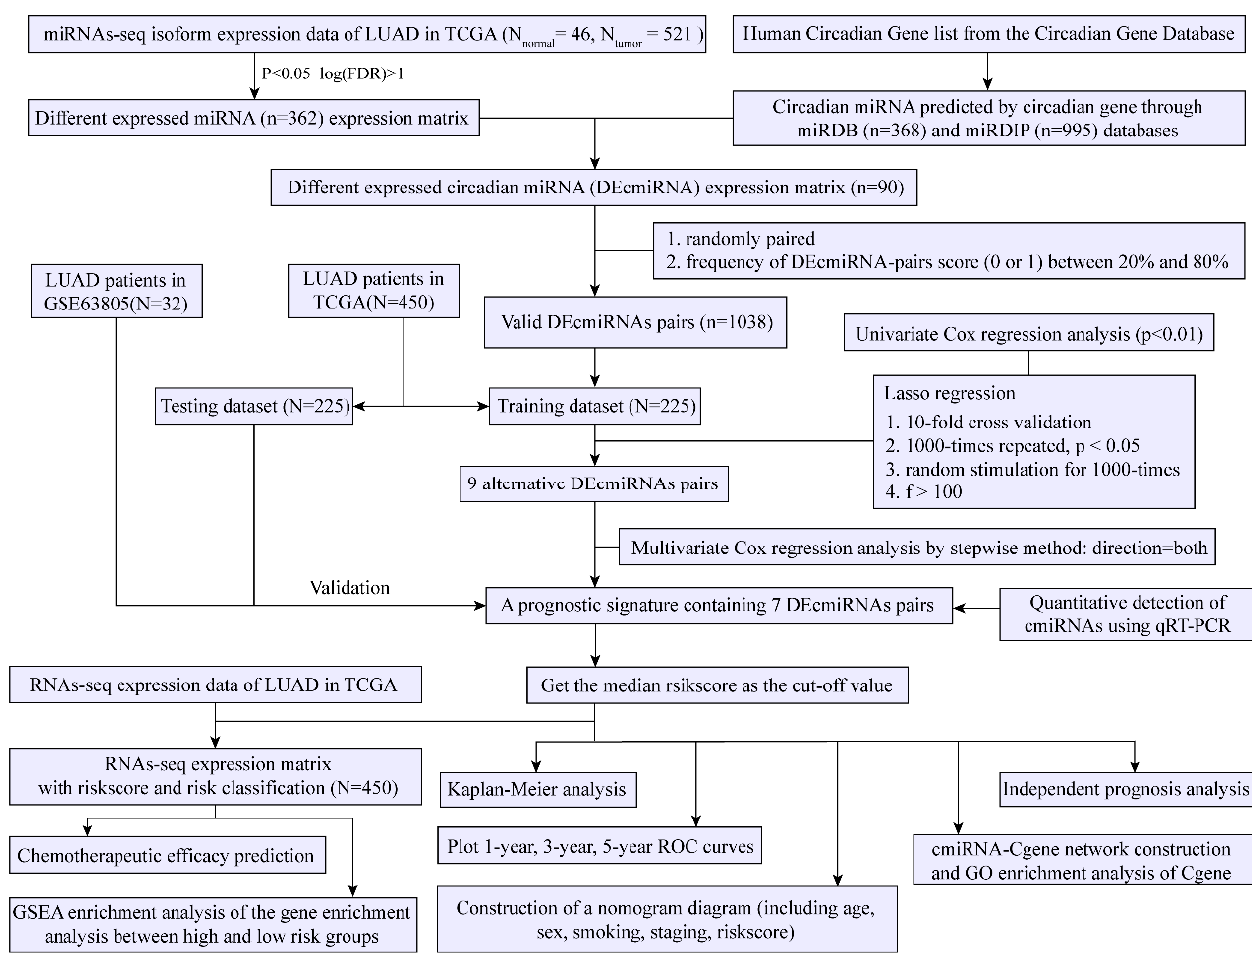
Figure 1. Overview of the study workflow.